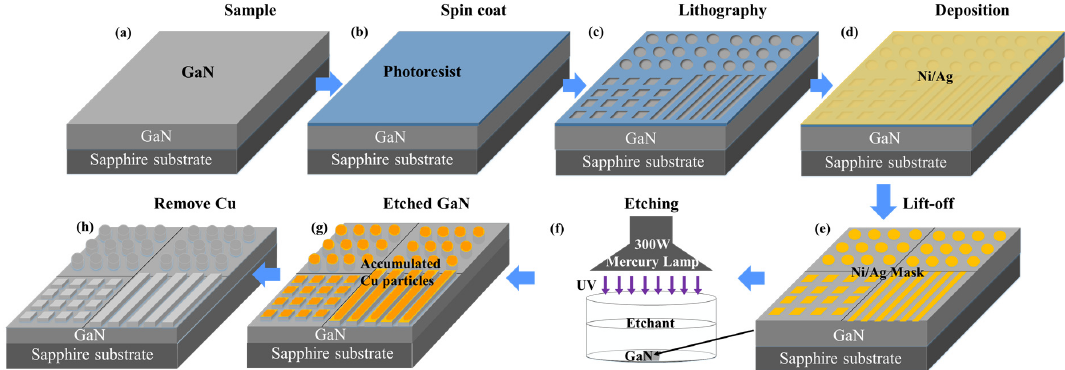
Figure 1. Schematic diagram showing the main steps of process flow in the fabrication of GaN: ( a ) GaN sample, ( b ) GaN coated by photoresist, ( c ) laser interference lithography, ( d ) Ni/Ag deposition, ( e ) Ni/Ag lift-off, ( f ) metal-assisted pho- tochemical etching, ( g ) MacEtch of GaN and accumulation of Cu on Ni/Ag, and ( h ) etched GaN surface after Cu and Ni/Ag